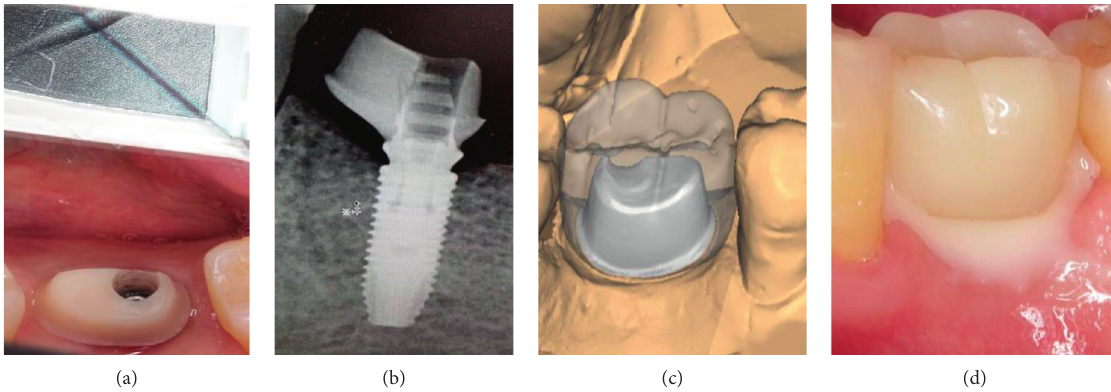
Figure 7: Stages of application of a customized composite abutment with immediate loading: (a) preparation, (b) checking the fit, (c) modeling of the provisional crown in the program, and (d) placement of the provisional crown.